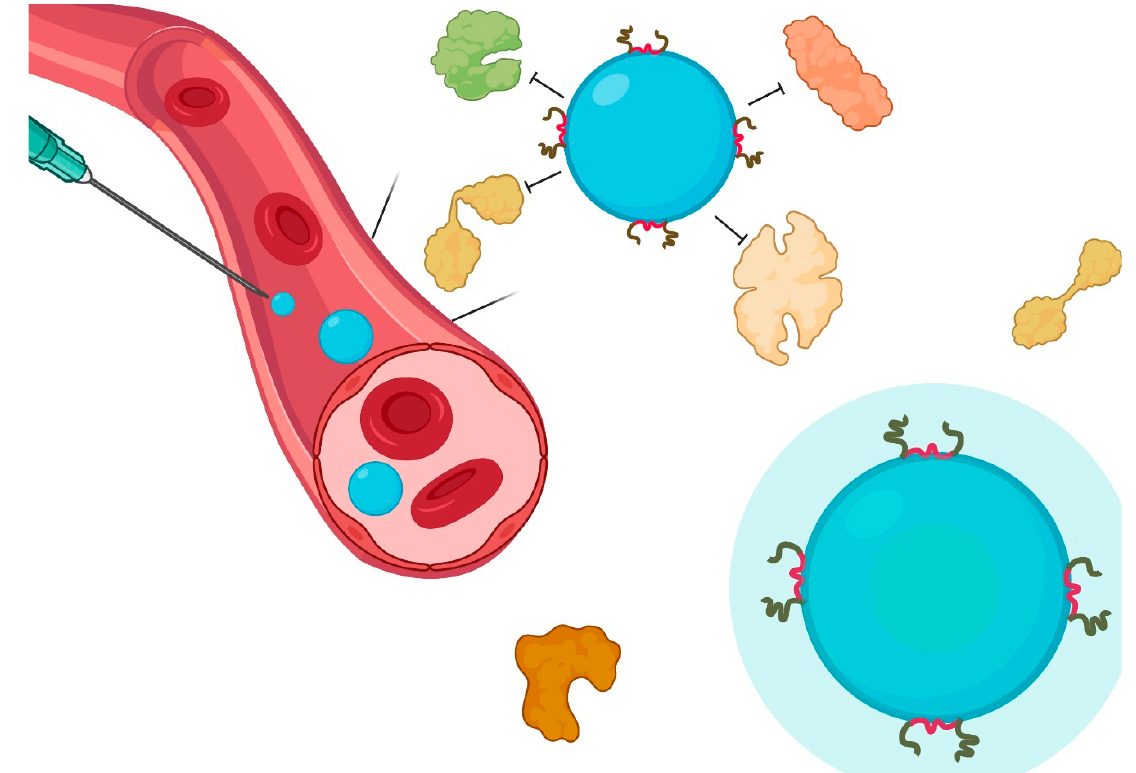
Figure 4. Interaction of non-ionic surfactants in biological systems. Adsorption of PS, PVA, or poloxamer allows a decrease in the deposition of proteins on the surface, increasing the circulation time. Local effects involve an absorption enhancer phenomenon with low inflammatory response.